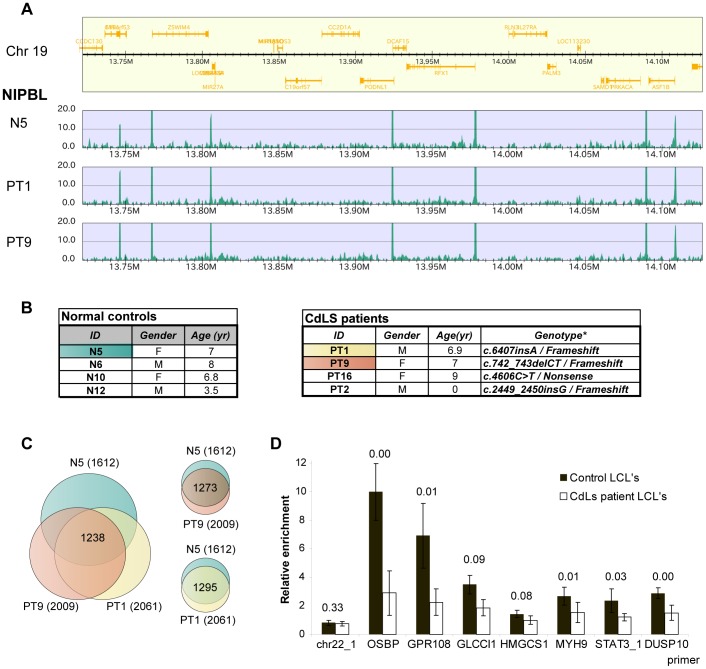
Position of NIPBL sites is conserved but the occupancy is reduced in CdLS.
A NIPBL ChIP-sequencing data of a region of chromosome 19 showing that NIPBL sites are conserved between CdLS patient cells and the control (M – Megabases). B CdLS patient and control cell lines used in this study. The cell lines highlighted were used for ChIP-sequencing. The tables were derived from [18]. Nucleotide numbering refers to the NIPBL B isoform cDNA sequence with GeneBank accession number NM_015384 and starting at the +1 position of the translation initiation codon. C Venn diagrams indicating the number of NIPBL binding sites observed in the different LCL's and also the sites consistently called in all three lines. The majority of binding sites is conserved, although each cell line displays cell-line specific sites. D NIPBL binding is reduced in LCL's derived from CdLS patients. NIPBL ChIP was performed for four patient-derived cell lines and four age and gender-matched controls and qPCR analysis was performed for seven NIPBL binding sites and one cohesin site. The enrichment compared to control IgG ChIP was calculated. The data for the individual cell lines are displayed in Suppl. Fig. S6. Here we present the average relative enrichment for all control and patient-derived lines, p-values derived with a Student test are indicated above the respective columns.